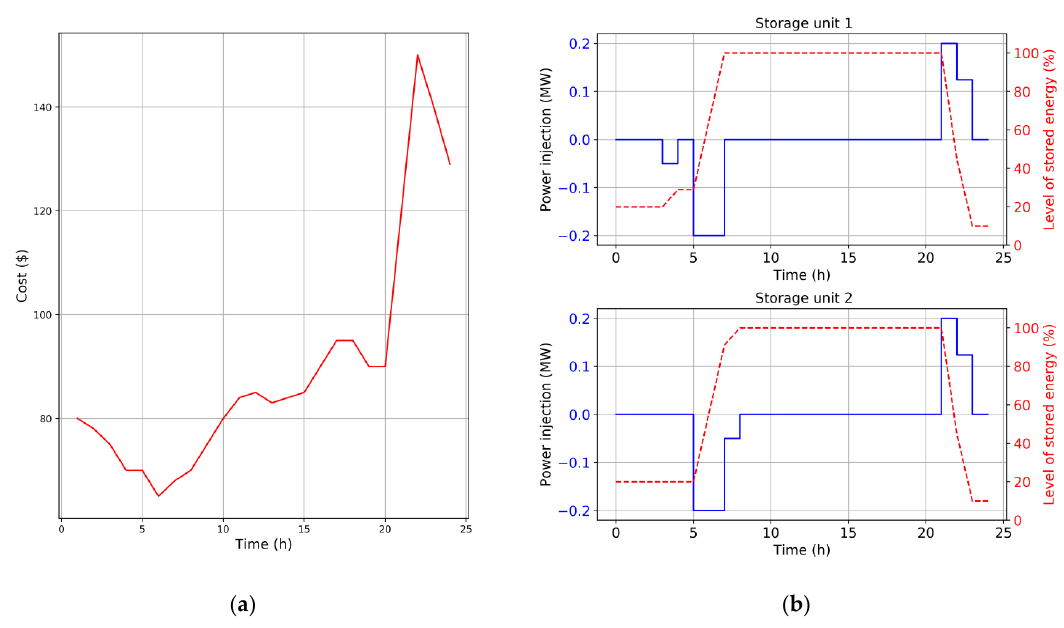
Figure 5. Results obtained for the second scenario considering a nonconstant cost profile. ( a ) Cost of the energy supply, ( b ) power injection and level of stored energy.